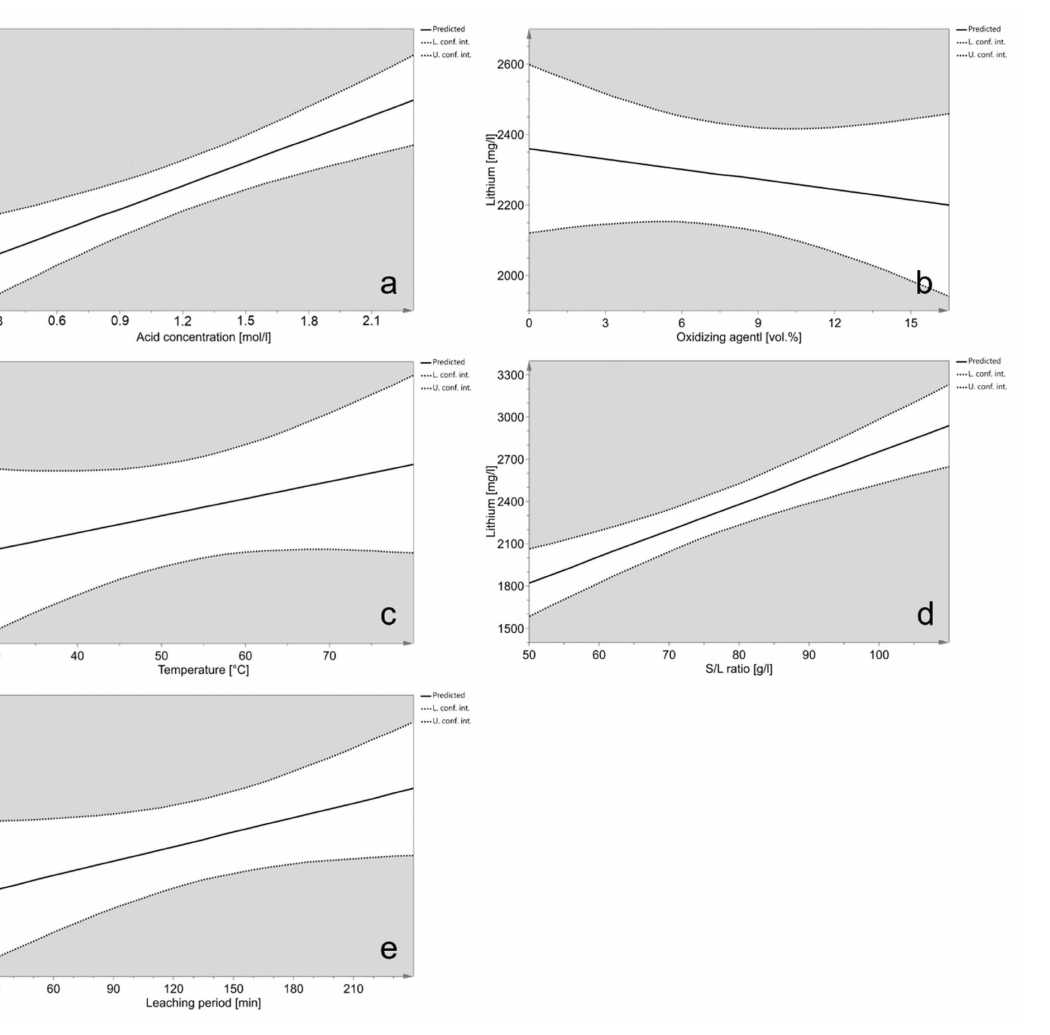
Figure 8. Influence of selected parameter ( a – e ) on the lithium content in the pregnant leach solution with otherwise constant parameters: ( a ) acid concentration, ( b ) oxidizing agent, ( c ) temperature, ( d ) S/L ratio, ( e ) leaching